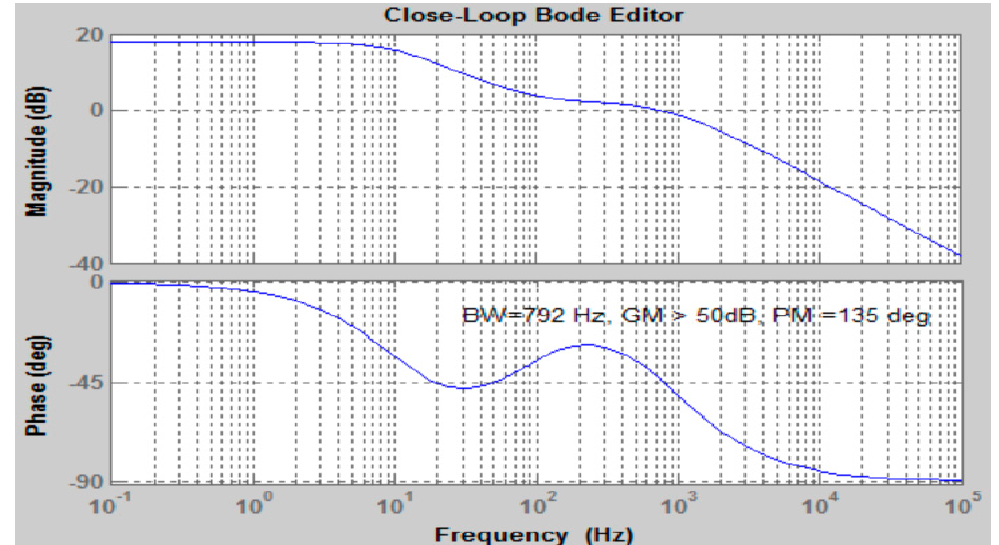
Figure 8. Frequency domain response of the voltage closed-loop transfer function of the fly-back converter.